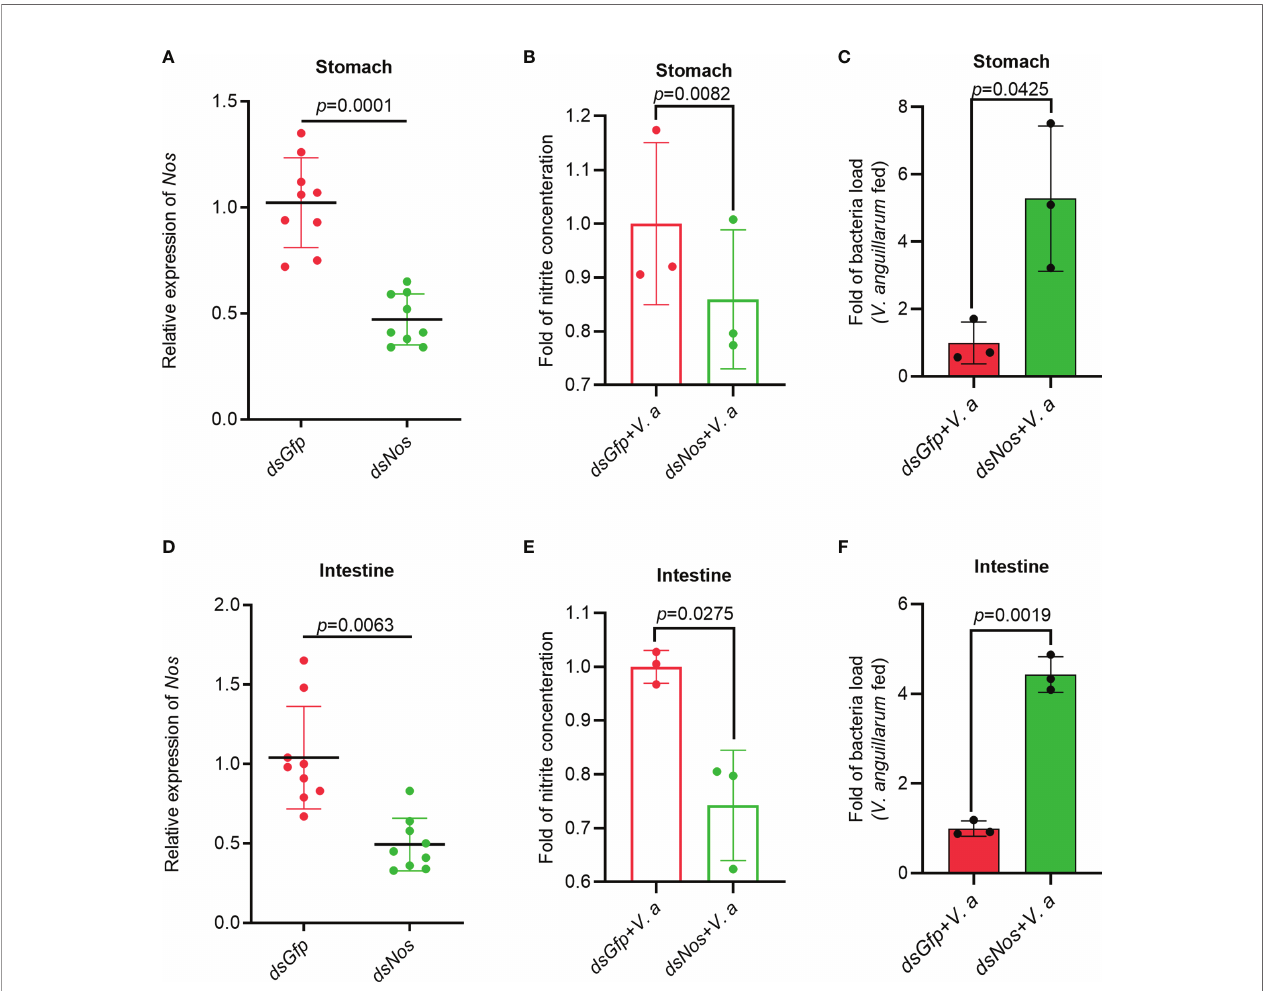
FIGURE 2 | The Nitrite concentration decreased and the bacterial load increased in the gastrointestinal tract of shrimp after knockdown of Nos . (A) Nos -RNAi ef fi ciency in the stomach analyzed using qPCR; dsGfp was used as the control. (B) The concentration of nitrite in the stomach of Nos -knockdown shrimp. (C) The bacterial load in the stomach of Nos -knockdown shrimp. (D) Nos RNAi ef fi ciency in the intestines analyzed using qPCR; dsGfp was injected as the control. (E) The concentration of nitrite in intestines of Nos -knockdown shrimp. (F) The bacterial load in the intestines of Nos -knockdown shrimp. Signi fi cance differences were analyzed using Student ’ s t-test and signi fi cance was accepted at p <